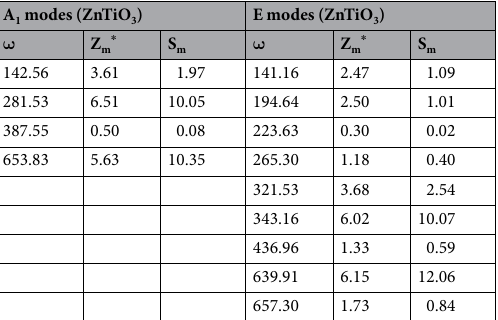
Table 6. The calculated mode effective charges (|e|), and mode-oscillator strengths (within 10 − 4 atomic units) corresponding to the zone-center transverse optical phonon modes of LiNbO 3 -type ZnTiO 3 .